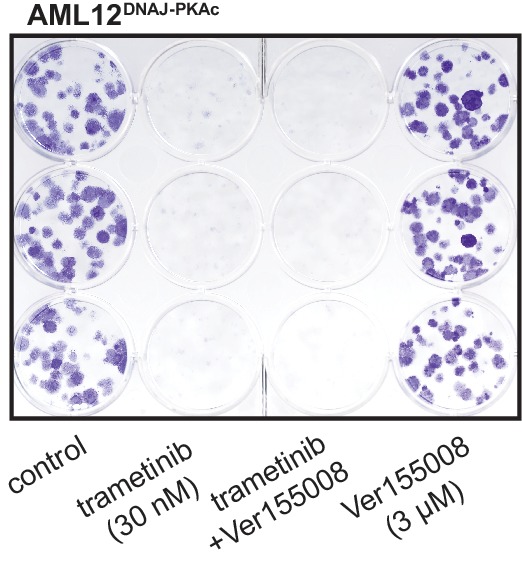
Effect of combination treatment with trametinib and Ver-155008 on cell growth.Clonogenic growth assay of AML12DNAJ-PKAc cells in the presence of the MEK inhibitor trametinib ± Hsp70 inhibition with Ver-155008.